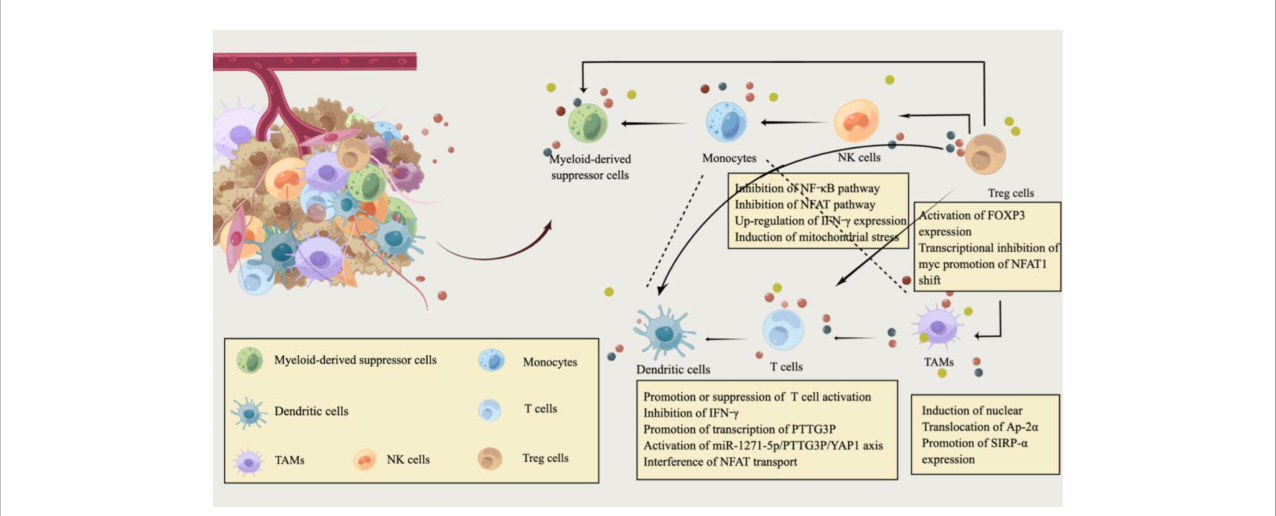
FIGURE 1 Immune modulation by lactate in the tumor microenvironment of CRC. The tumor microenvironment (TME) of CRC is fi lled with various cell populations. In addition to CRC cells, there are a variety of immune cells and tumor stromal cells. Similarly, the metabolic reprogramming of CRC cells is also inseparable from the regulation of the immune system, and immune metabolism plays an essential role in the pathogenesis and progression of CRC. CRC cells consume most nutrients and secrete excessive lactate into the CRC extracellular microenvironment. Hypoxic and lactate-acidi fi ed TME have speci fi c immunosuppressive properties. Lactate also regulates the metabolism of innate and adaptive immune cells by affecting the function of T cells, natural killer (NK) cells, and dendritic cells(DC). Lactic acid can attract Treg cells and help Foxp3 + regulatory T (Treg) cells to maintain their immunosuppressive function in an acidic environment. In addition, lactate, as an extracellular molecule regulating tumor-associated macrophages(TAM) polarization, affects the phagocytic activity and carcinogenic effect of TAM by promoting Sirp a expression. This image was designed by Qianhui Sun and drawn by Figdraw. All authors con fi rm the originality of it and retain copyright to